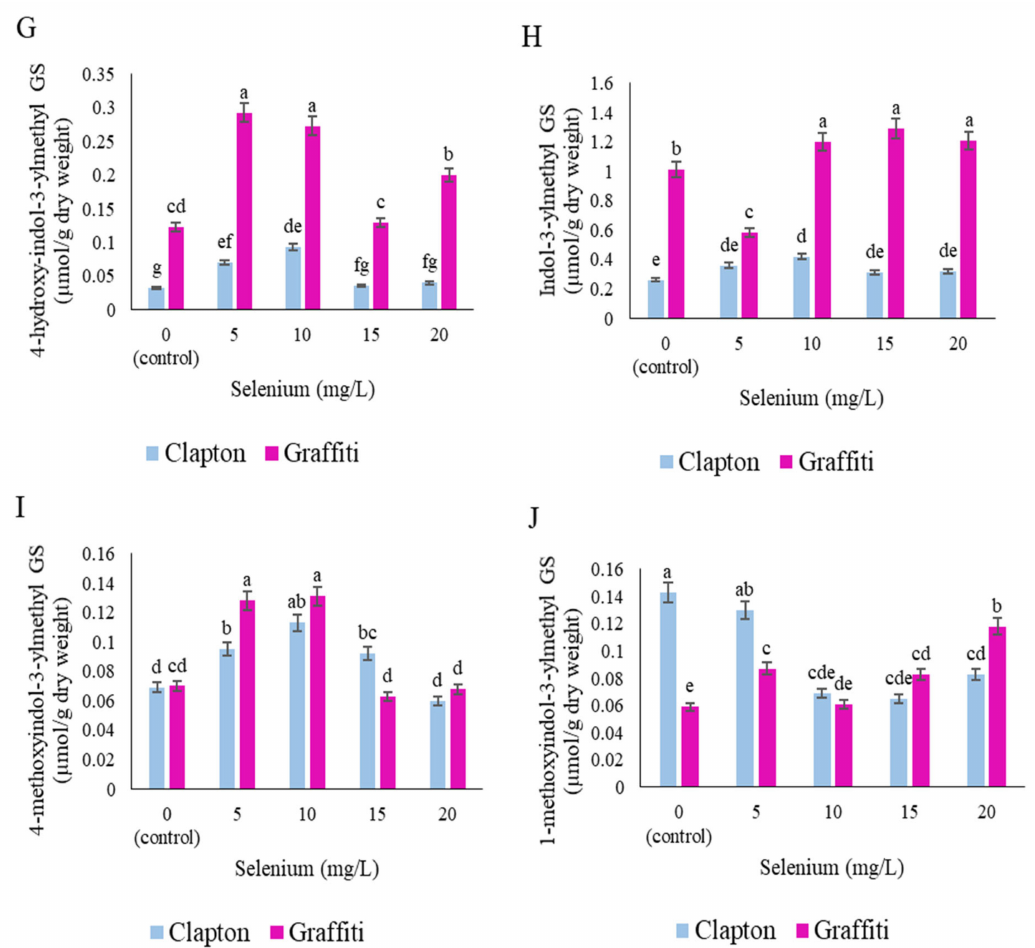
Figure 3. Mean comparison of sodium selenate treatments on glucosinolate (GS) profile of cauliflower florets (“Clap- ton, “Graffiti”), ( A ) Total GS, ( B ) Aliphatic glucosinolates, ( C ) Indolic glucosinolates, ( D ) 3-methylsulfinylpropyl GS, ( E ) 3-methylthiopropyl, ( F ) 4-methylsulfinylbutyl GS, ( G ) 4-hydroxyindol 3-ylmethyl GS, ( H ) indol-3-ylmethyl GS, ( I ) 4-methoxyindol-3-ylmethyl GS, ( J ) 1-methoxyindol-3-ylmethyl GS. Shown are the mean ± standard deviations of three replications. Bars marked by the same letter are not significantly different ( p ≤ 0.05, Duncan’s multiple range